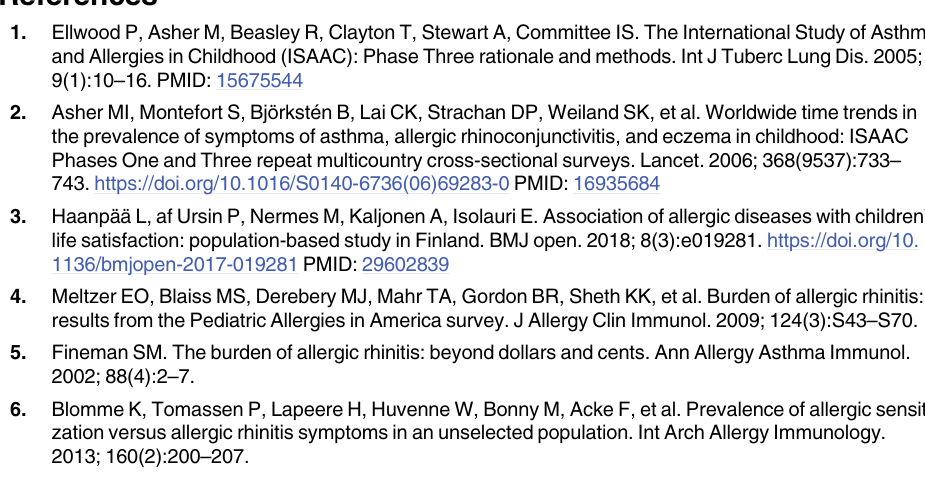
S1 Table. Questionnaire for rhinitis symptoms from the Korean International Study of Asthma and Allergies in Childhood